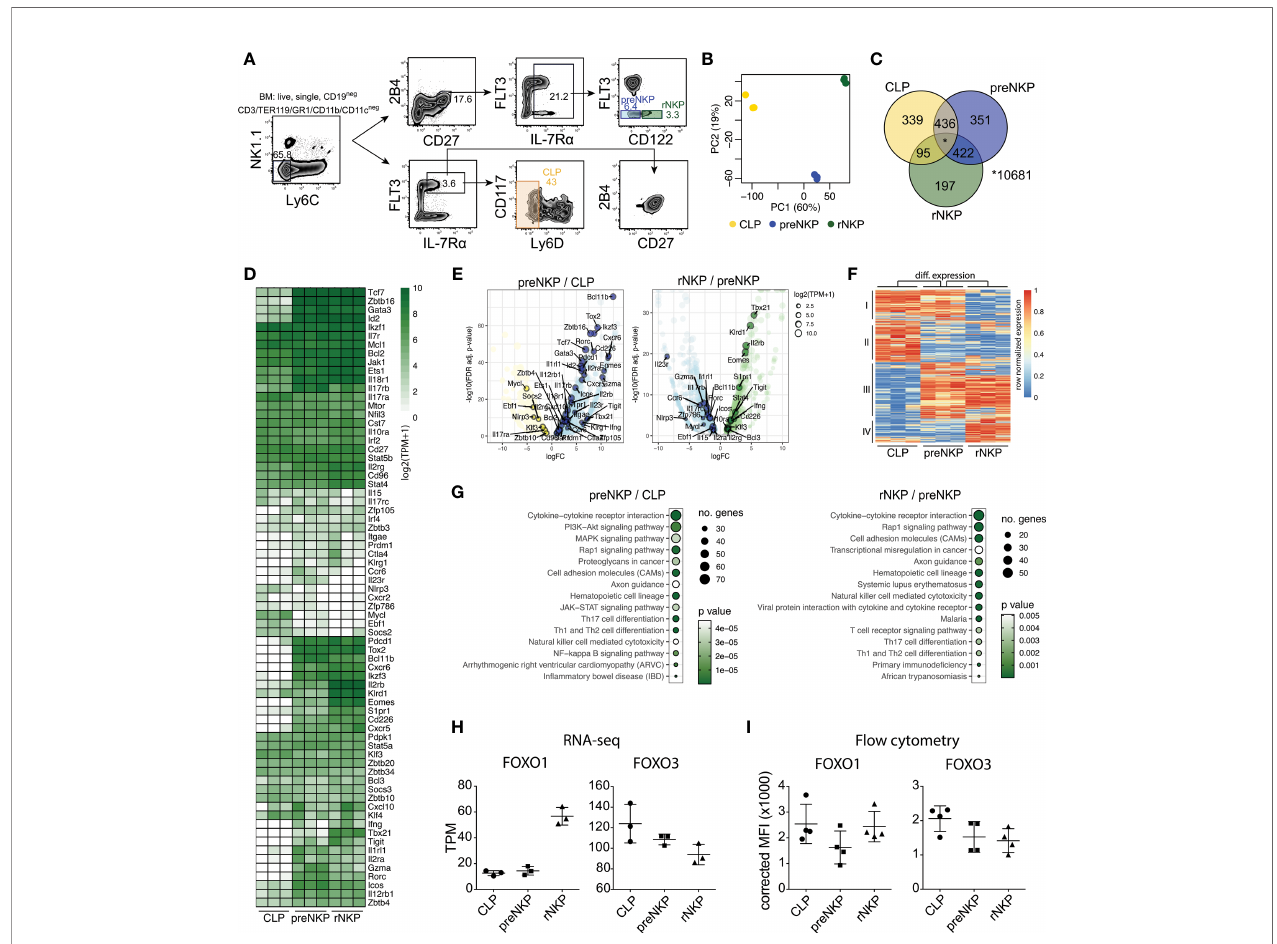
FIGURE 1 | The rNKP gene expression program is established gradually in the CLP to preNKP and preNKP to rNKP developmental transitions. (A) Gating strategy for FACS sorting of BM NK cell progenitors (LY6D neg CLP, preNKP and rNKP). (B) Principal component (PC) analysis of RNAseq data from indicated cell populations FACS sorted from WT (FOXO1 fl ox/ fl ox FOXO3 fl ox/ fl ox ) mice (n = 3 per population). The variation explained by each PC is displayed in parenthesis. (C) Venn diagram showing the overlap between expressed protein-coding genes in indicated populations. Genes with ≥ 0.3 transcript per million (TPM) in all three replicas were considered expressed. (D) Hierarchically clustered heatmaps showing expression of protein-coding genes important for NK cell or ILC development. (E) Volcano plots showing differentially expressed genes for the comparisons between preNKP versus CLP (left panel) and rNKP versus preNKP (right panel). Differentially expressed genes (regulated by ≥ 2-fold at an FDR<0.05) are highlighted in color. Circle sizes indicate expression values in log2(TPM+1). (F) Hierarchically clustered heatmap showing row normalized expression of differential expressed genes (identi fi ed in E ). Clusters I-IV are indicated. (G) KEGG pathway analysis of differentially expressed genes comparing preNKP versus CLP (left) and rNKP versus preNKP (right). Genes regulated by ≥ 2-fold at an FDR<0.05 were considered differentially expressed and used in the analysis. The size and color of the circles indicate the number of genes in each category and signi fi cance of enrichment respectively. (H – I) Expression levels of FOXO1 and FOXO3 from indicated progenitor populations, obtained by (H) RNA-seq or (I) fl ow cytometry. Dots represent individual analysed animals ( n = 2-4). Bars indicate mean and SD. Data shown in (I) is from one representative experiment out of two independent